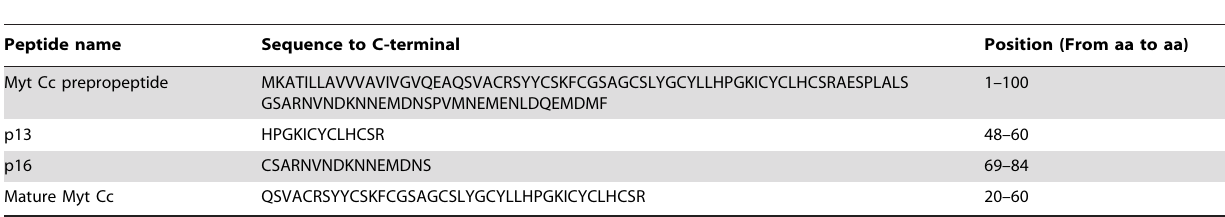
Table 1. Sequence and relative position of synthetic peptides used in present study.